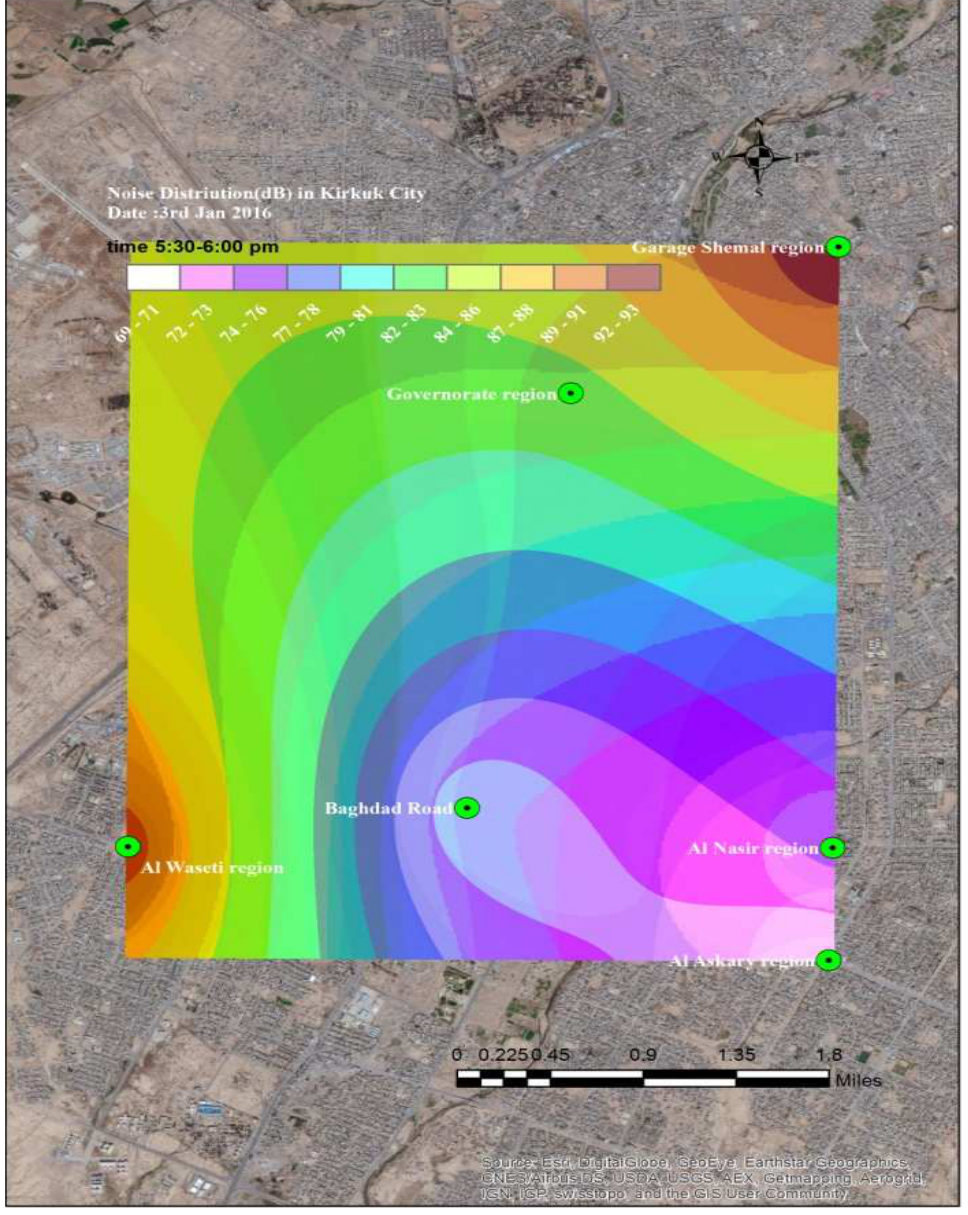
Fig. 2. Daily Noise Distribution for the peak morning and evening traffic flow 3 Jan. 2015 Kirkuk